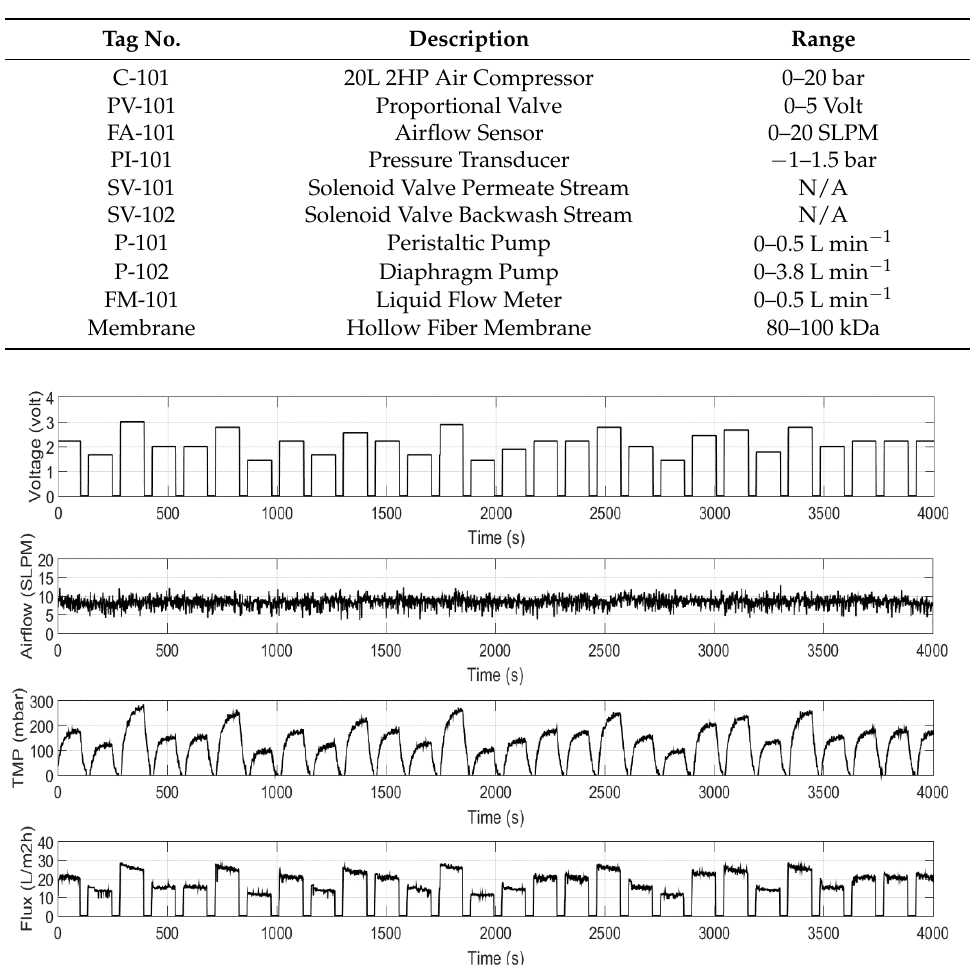
Figure 2. Dataset from the SMBR filtration experiment.